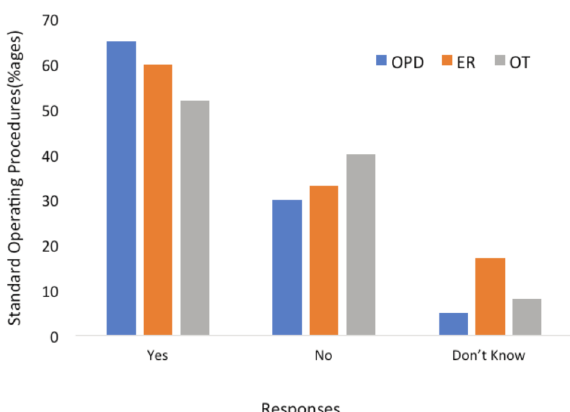
Bar graph based on the responses showing outpatient Fig. 2: departments (OPD), emergency (ER) and operation theatres (OT) with and without standard operating procedures.